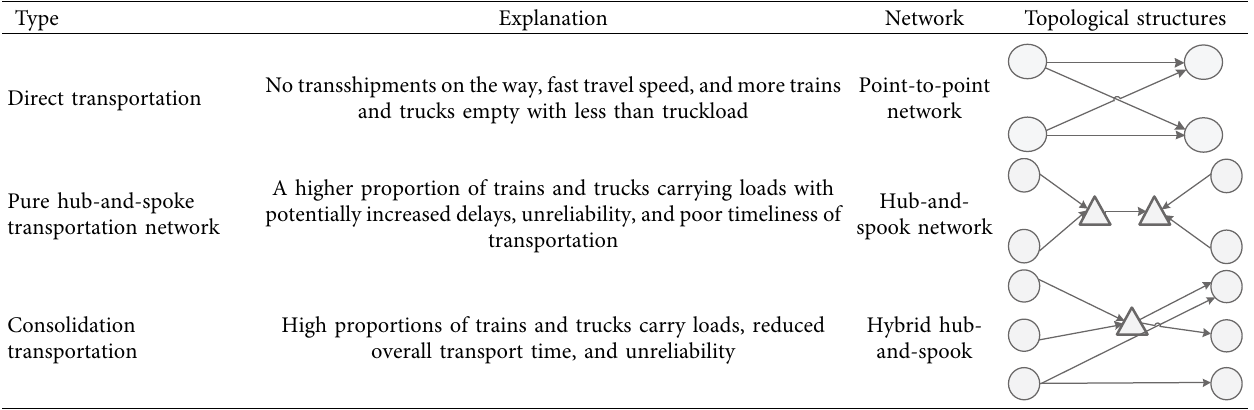
Table 1: Transportation nodes and network topological structures.